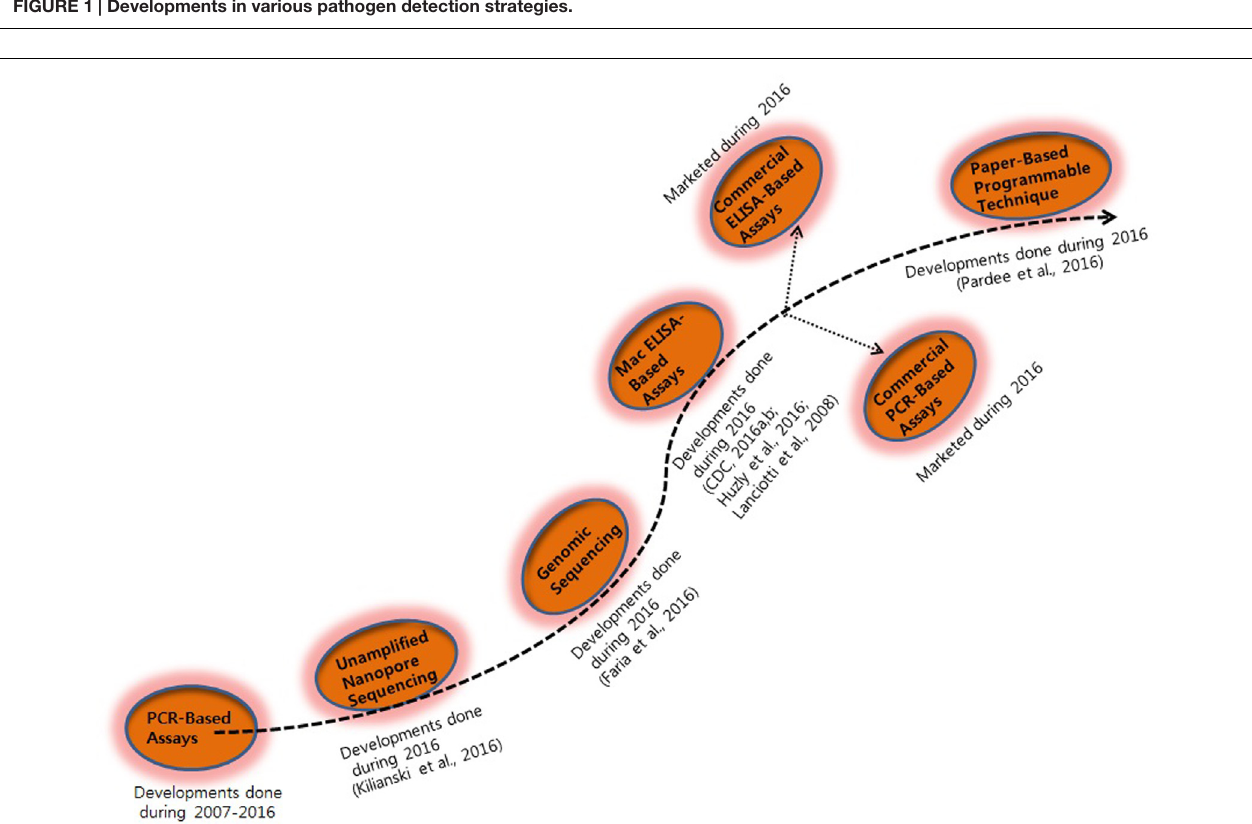
FIGURE 2 | Consistent major year-wise efforts in the development of detection assays for Zika virus.